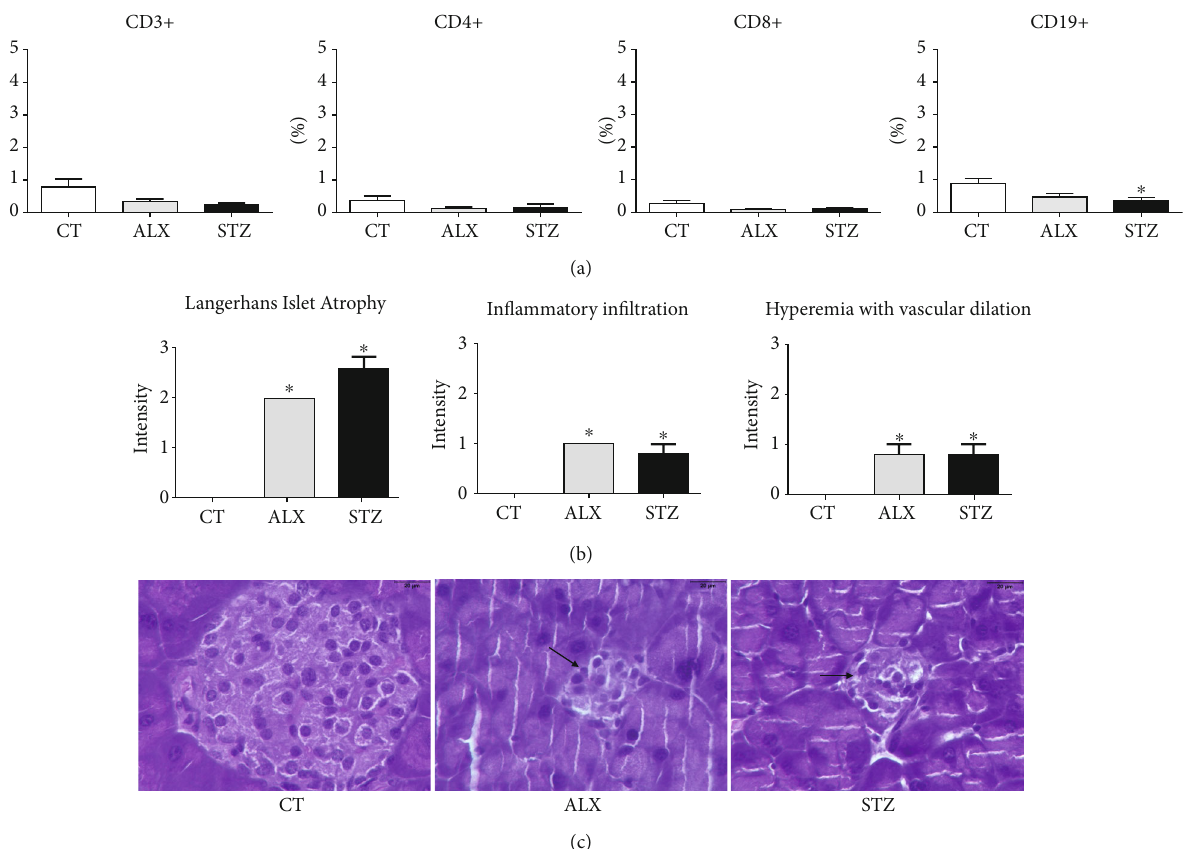
Figure 6: Short-term diabetogenic e ff ects of ALX and STZ on the pancreas. T1D was induced as described in Methods, and (a) pancreases from the CT, ALX-, and STZ-treated groups were collected on the 15 th day, and the pancreatic cells were characterized according to the cell surface markers CD3, CD4, CD8, and CD19 by fl ow cytometry. (b) Evaluation of structural changes in the pancreas. (c) Representative microphotographs of 3 μ m sections of pancreas tissue stained with HE (scale 20 μ m). The arrows indicate atrophy of the islets of Langerhans in diabetic animals induced with ALX or STZ. Data are presented as mean ± SEM , ∗ p ≤ 0 : 05 (6-9 animals per